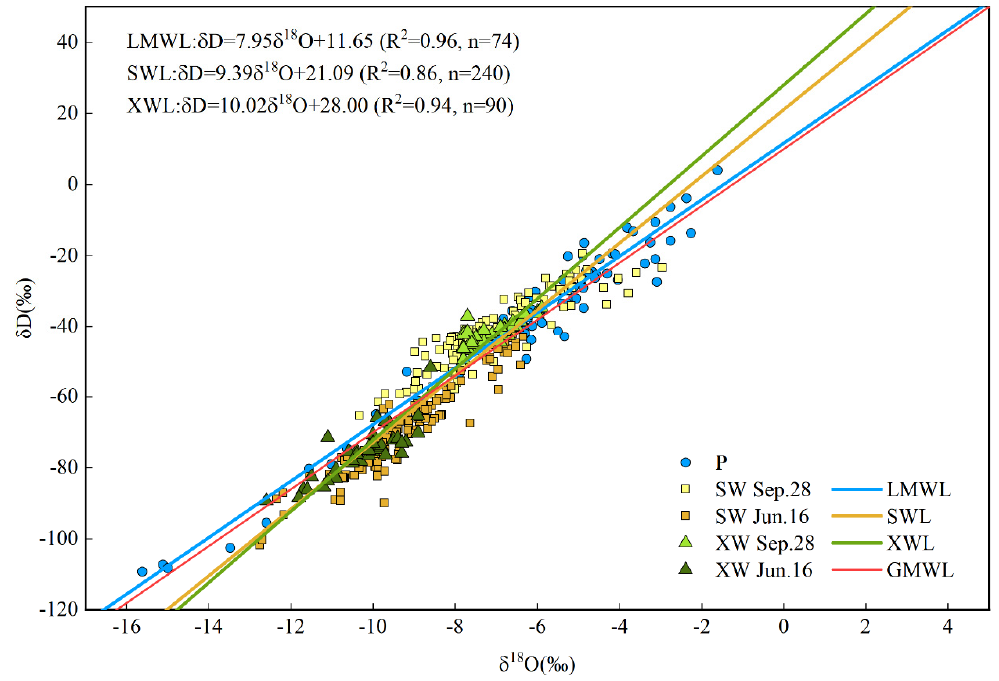
Figure 5. Linear regression relationship between δ D and δ 18 O in rainfall, soil water and xylem water during the sampling periods.